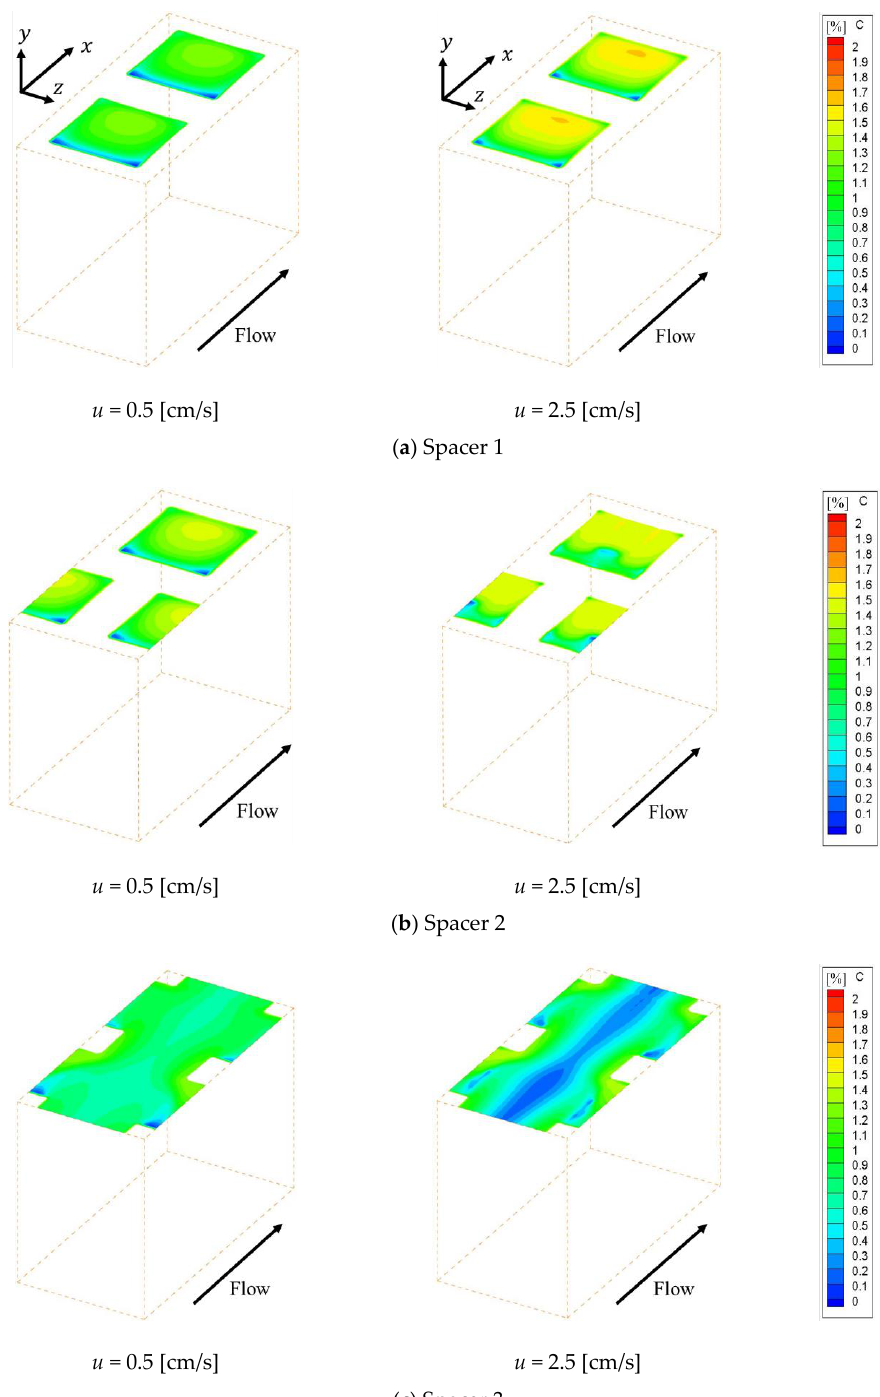
Figure 4. Concentration fields on an ion exchange membrane with porous spacers. ( a ) and ( b ) High concentration regions are formed at the attachment point of recirculation flow, while the low concentration regions are formed behind the structure; ( c ) Low concentration regions are observed on the center of the membrane along the main flow, which was not seen from ( a ) and ( b ).